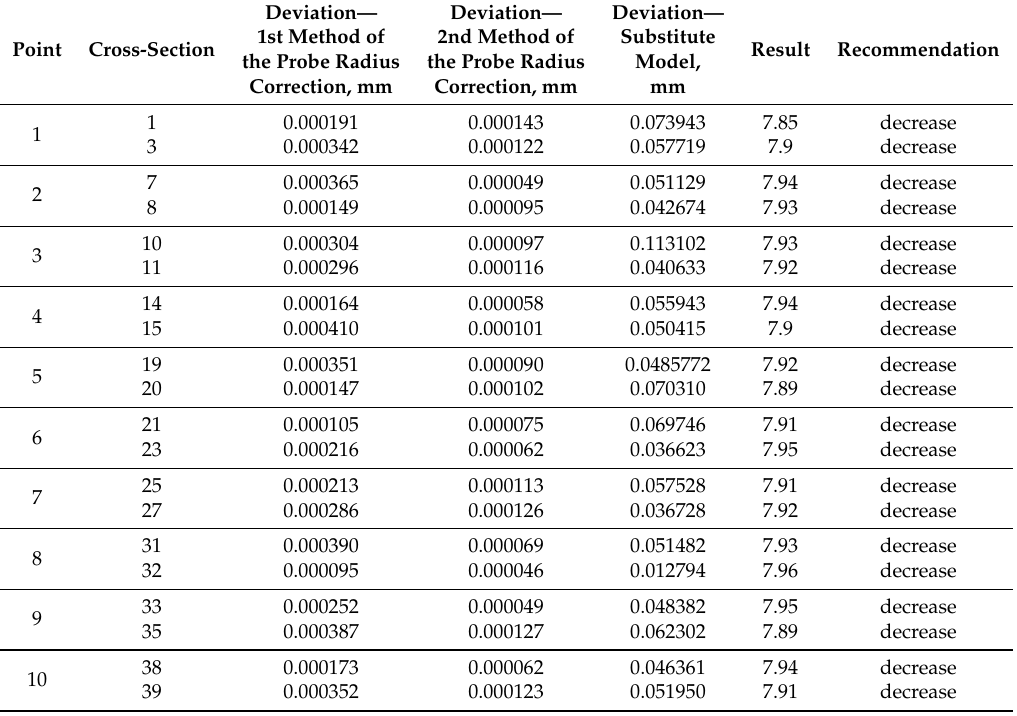
Table 6. The results of the second part of the simulation investigations and the recommendations regarding the number of measurement points located along the selected measured cross-sections for the second free-form